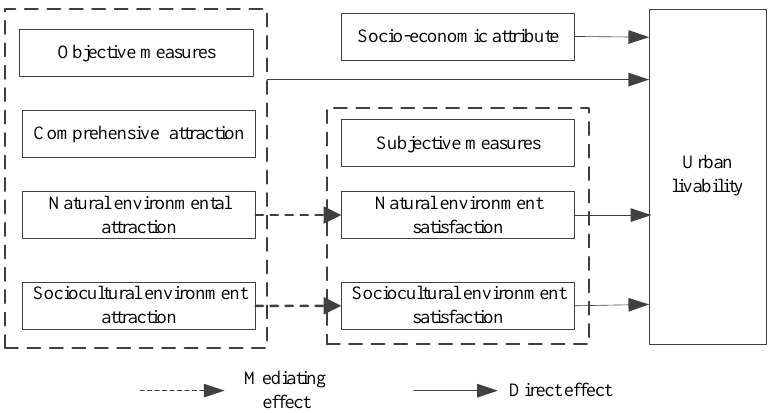
Figure 1. Conceptual framework of the study.